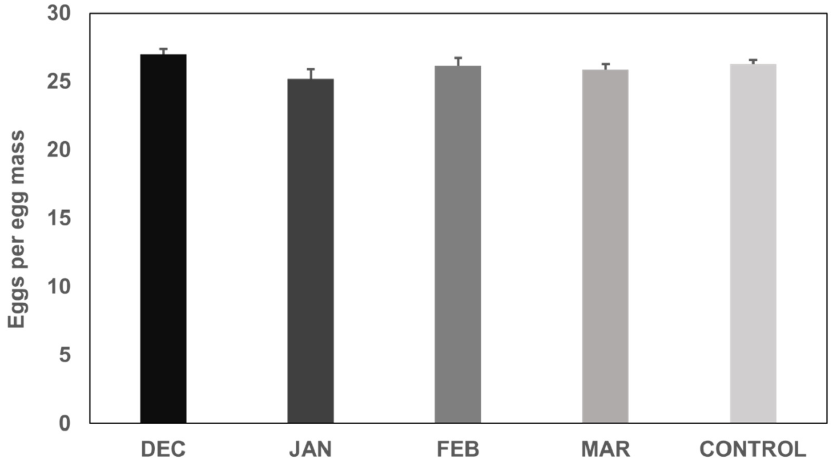
Figure 4. Number of eggs per egg mass (mean ± S.E., n = 60) laid by Halyomorpha halys females that overwintered in natural outdoor conditions until December 2020, January, February and March 2021 and were then transferred to 26 ◦ C. A laboratory colony maintained at 26 ◦ C was used as control. No statistically significant differences were observed ( p = 0.165).